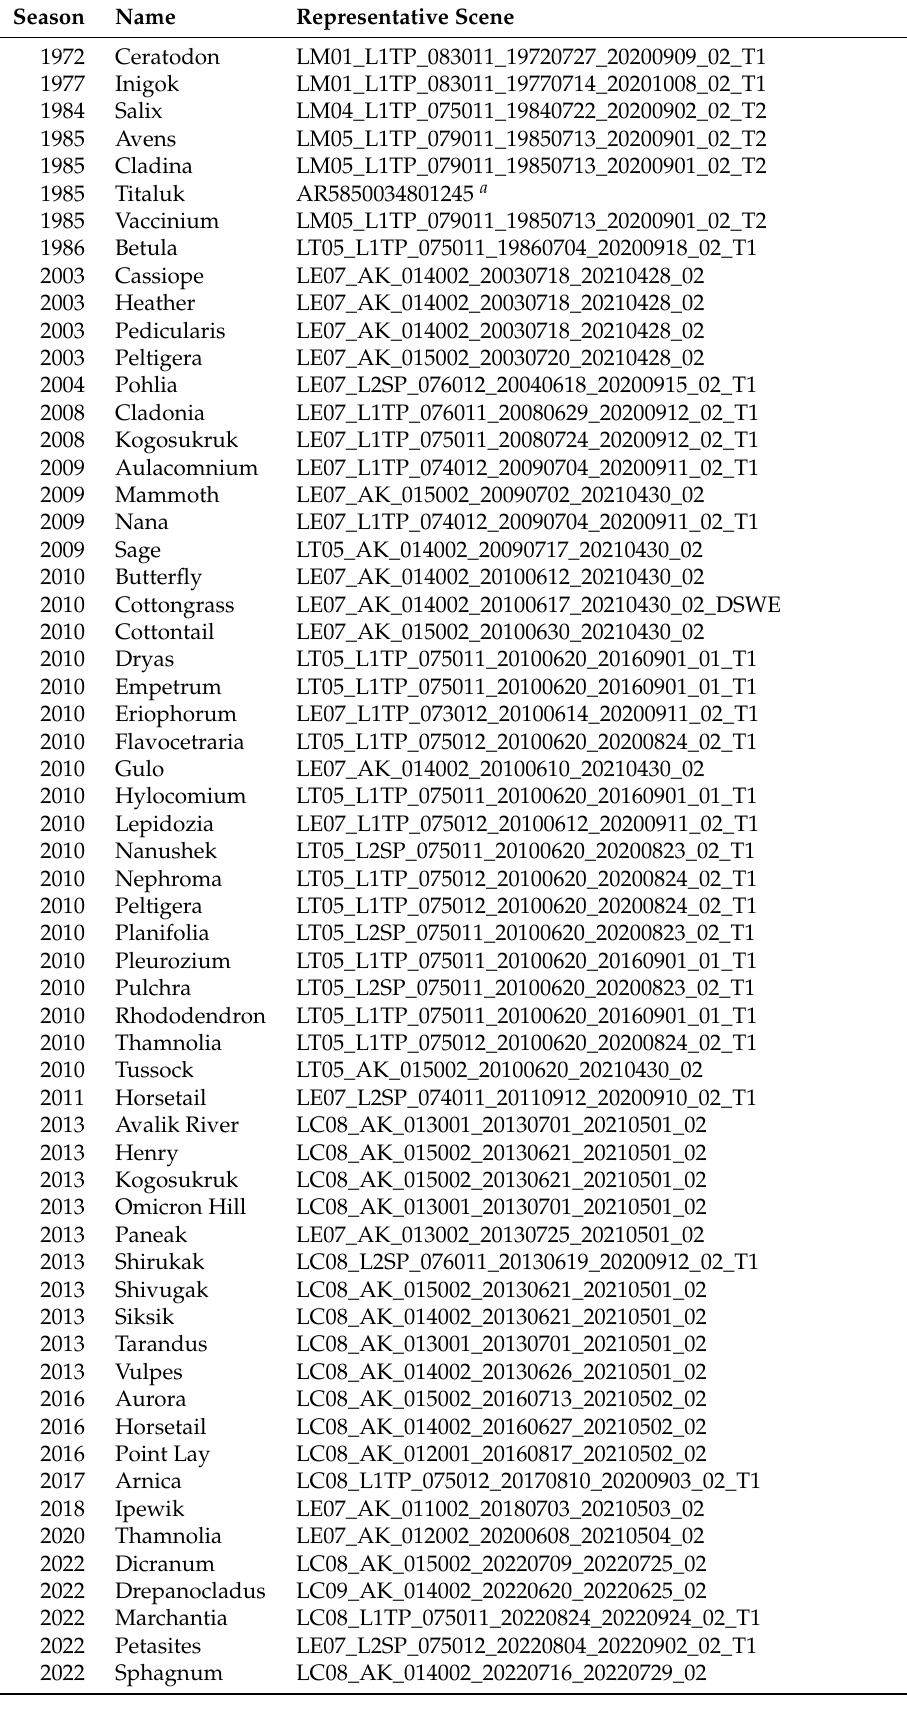
Table A2. Attributes of record-worthy burns (continued from Table A1); a indicates aerial